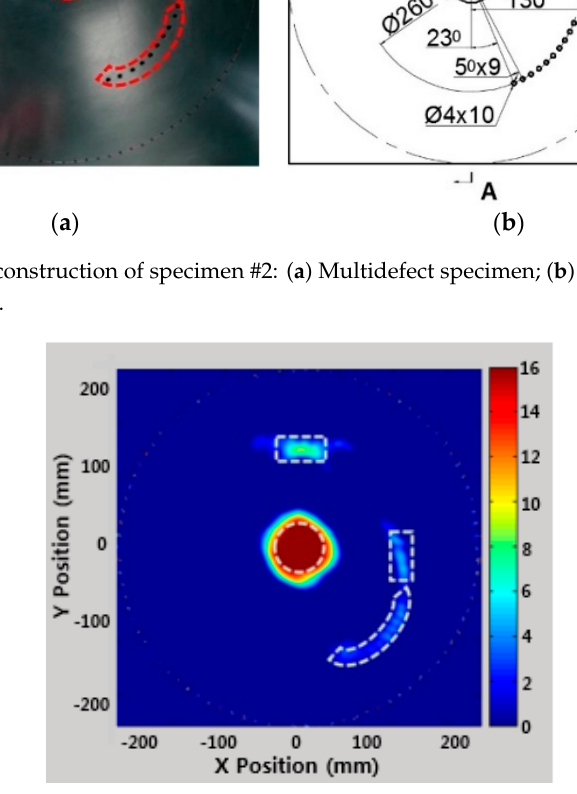
Figure 26. Multidefect imaging using the DHB algorithm.